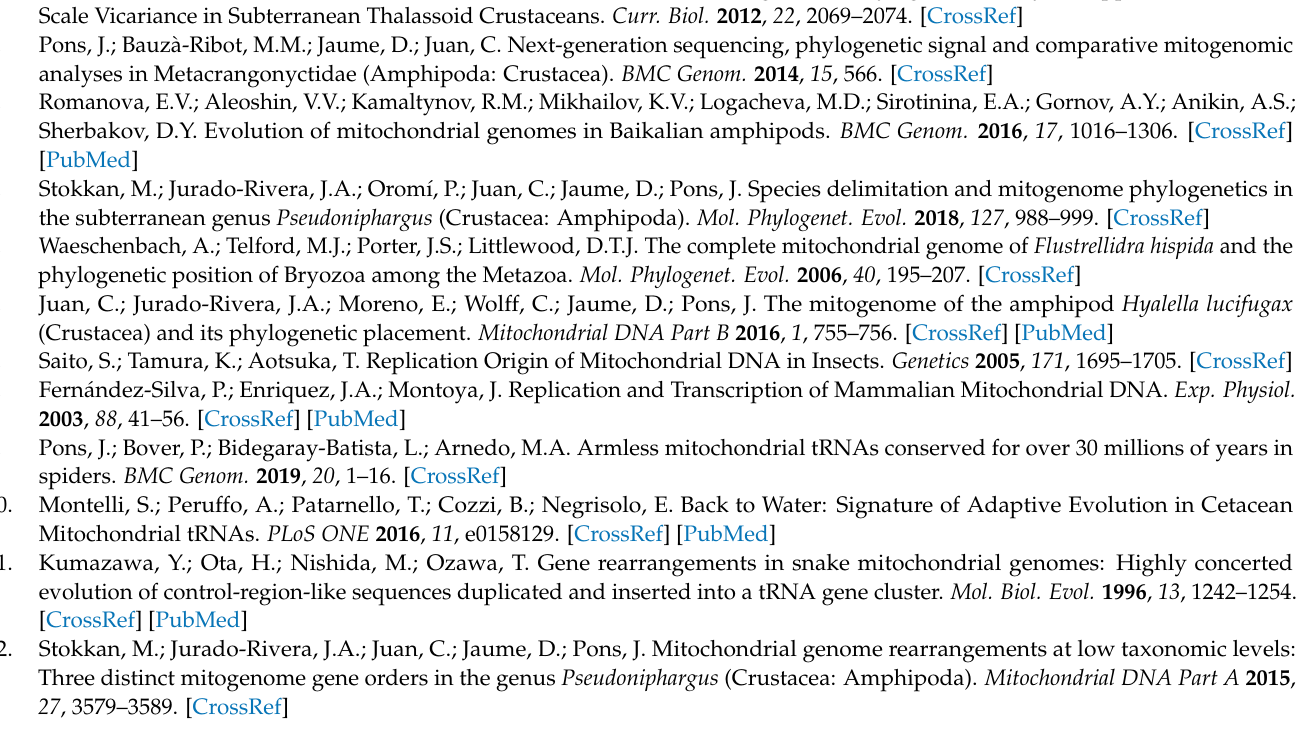
genome arrangements obtained with CREx are also shown, Figure S2: Heatmap of the average amino acid composition frequencies (top panel) and standard deviation (bottom panel) across Hyalella species, Figure S3: Heatmap of the average codon frequencies per thousand codons (top panel) and codon fraction per amino acid (bottom panel) across Hyalella species, Figure S4: Plot relating codon usages (ENC and MILC) vs. GC frequencies of third codon sites at fourfold degenerated amino acids at the gene level (top panel) and by coding strand (bottom panel), Figure S5: Mitochondrial gene order in four different amphipods: the whole Metacrangonyctidae family, Parhyale hawaiensis , Pseudoniphargus daviui and Platorchestia . Genes located above the central line correspond to genes coded on the plus-strand, whereas those coded on the minus-strand appear below. Blocks in grey correspond to non-coding segments attributed to control